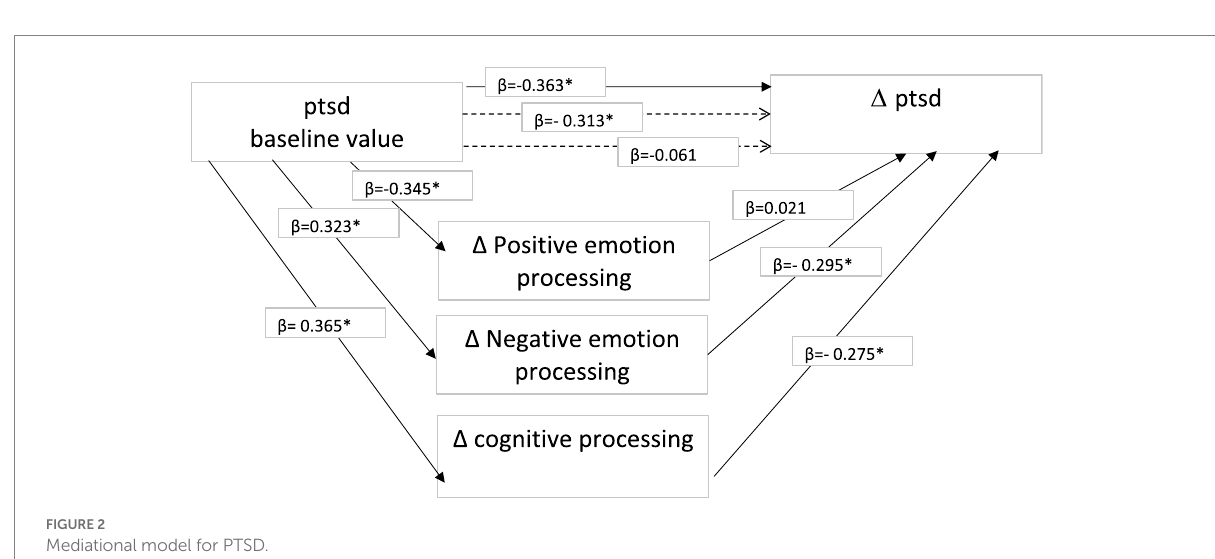
FIGURE 2 Mediational model for